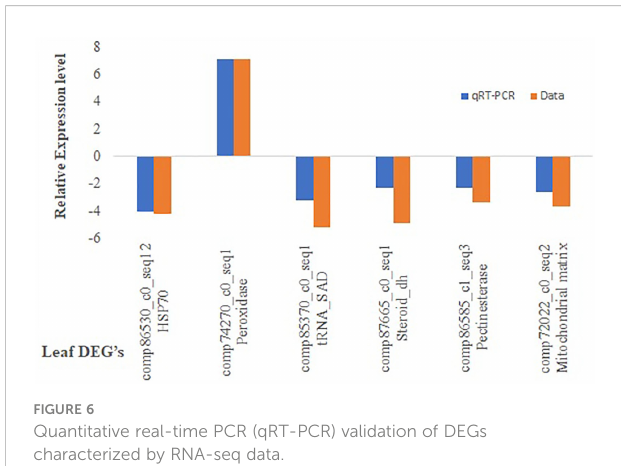
FIGURE 6 Quantitative real-time PCR (qRT-PCR) validation of DEGs characterized by RNA-seq